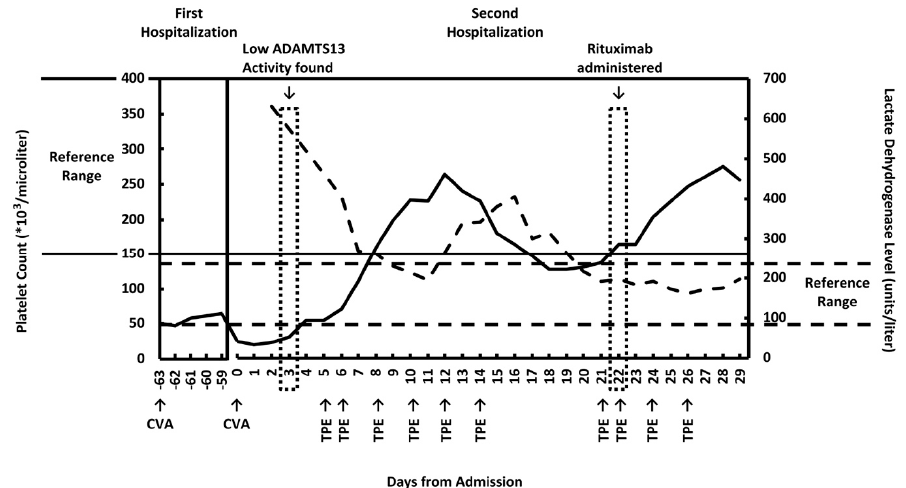
Figure 1. Platelet count and lactate dehydrogenase (LDH) levels over the course of hospitalization. Solid line: platelet count. Dotted line: lactate dehydrogenase levels. CVA = cerebrovascular accident. TPE = therapeutic plasma exchange. Dates of TPE and rituximab administration, known CVA, and discovery of low ADAMTS13 activity are marked. Platelet counts from the patient’s first hospitalization, which was between 63 and 59 days before her second admission, are prior to the diagnosis of thrombotic thrombocytopenic purpura (TTP). Days 0 through 29 refer to the patient’s second hospitalization, in which TTP was diagnosed and treated.